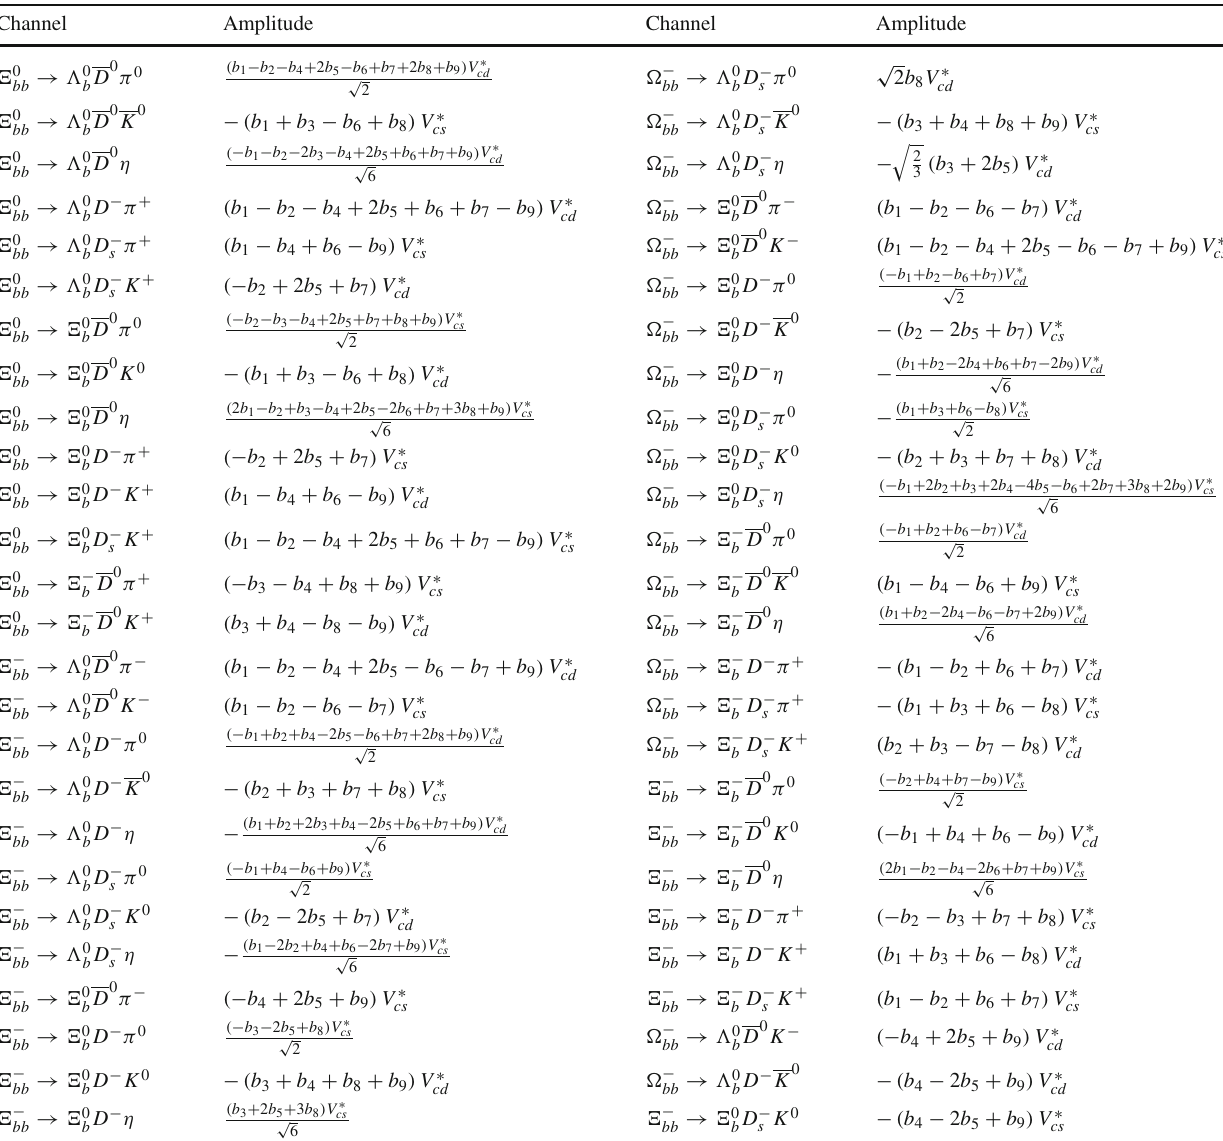
Table 20 Doubly bottom baryon decays into a bqq (anti-triplet), an anti-charmed meson and a light meson Channel Amplitude Channel